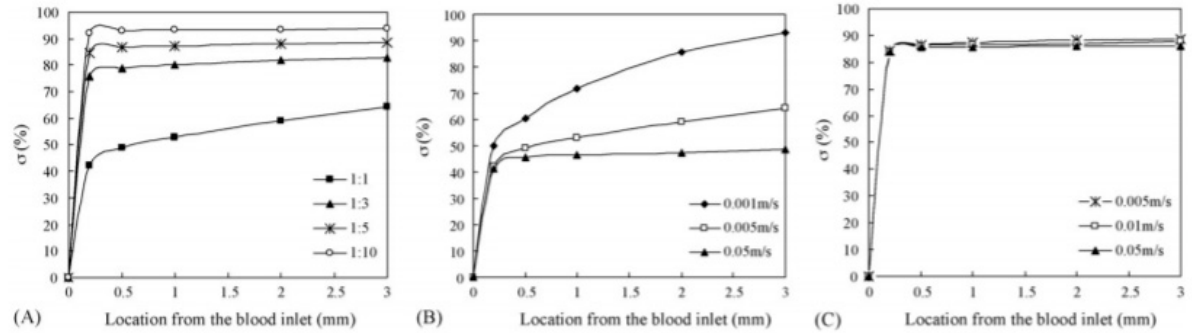
Figure 2. Numerical evaluations of σ at a variety of flow conditions are shown in [12]. ( A ) The flow rate of blood was 0.005 m s − 1 , whereas the flow rate of the lysis buffer was 0.015, 0.025, 0.005, and 0.05 m s − 1 . ( B ) The ratio of the blood’s flow rate to the lysis buffer was 1:1. ( C ) The ratio of the blood flow rate to the lysis buffer was 1:5. Adapted with permission from [12]. Copyright 2007 Copyright Elsevier.